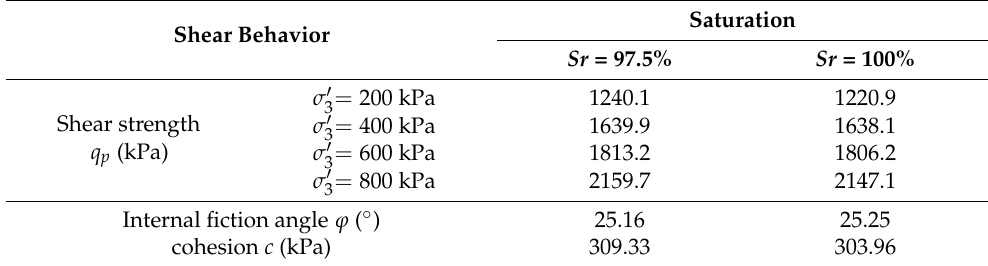
Table 7. Comparison in shear behavior between coral sand with 97.5% saturation and 100% saturation. Shear